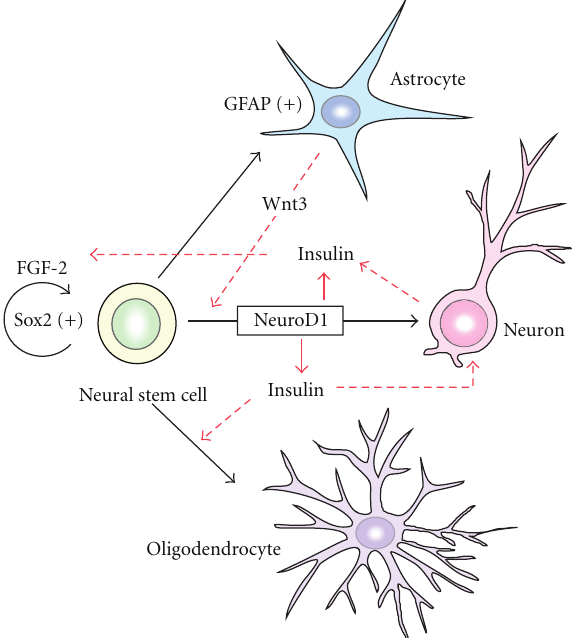
Figure 1: Schematic representation of the signals and transcription factors regulating adult neurogenesis. Undi ff erentiated adult neural stem cells express Sox2 transcription factor for the self-renewal function. FGF-2 promotes the proliferation of neural stem cells and insulin and IGF-1, and IGF-2 support the process. Astrocyte-secreted Wnt3 promotes the neuronal di ff erentiation from neural stem cells by the activation of NeuroD1 transcription factor in the neuronal progenitor cell. The NeuroD1 transcription factor triggers the expression of insulin gene. Insulin, IGF-1, and IGF-2 promote the oligodendrocyte di ff erentiation from neural stem cells. They also promote neuronal survival and possess the protection ability of mature neurons by preventing their natural cell